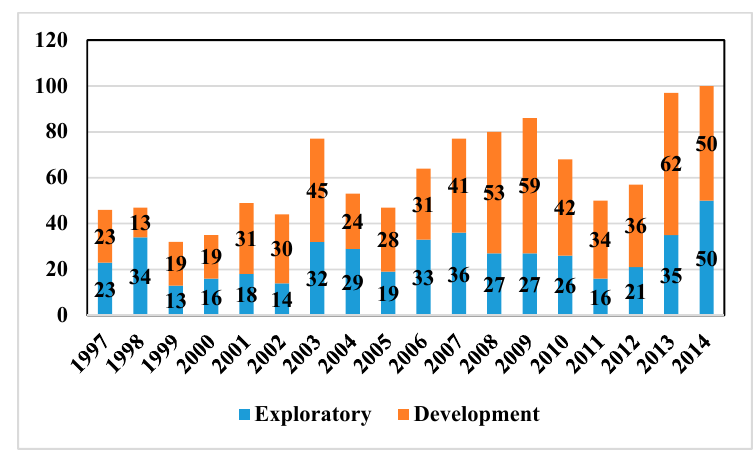
Figure 6. Exploratory and development wells drilled in Pakistan.